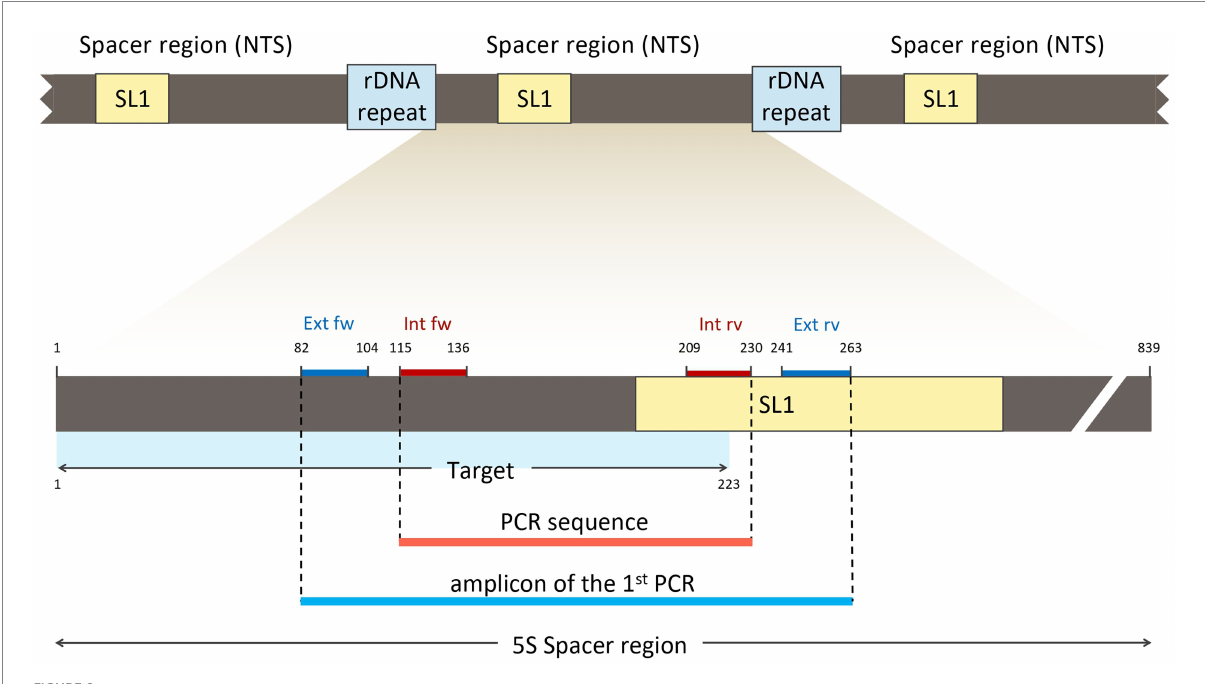
FIGURE 6 Location of the external (Ext fw and Ext rv) and internal primers (Int fw and Int rv) in relation to the SL1 region and the target sequence.